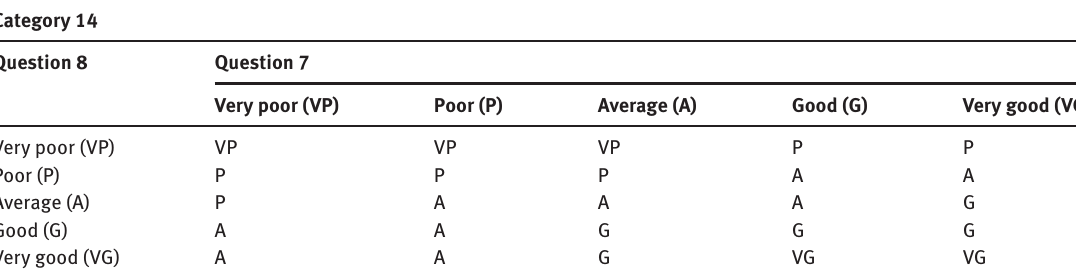
Table 2: Multiexpert FRBS for Category 14 Node in Four-Level FRBS as Illustrated in Figure 1. Category 14